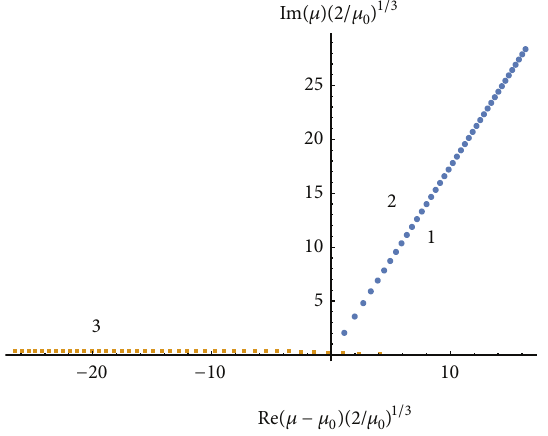
Figure 1: Position of Regge poles for attractive Fermi-potential. Shown are the poles, corresponding to near-surface states. 1: narrow quasi-bound states (whispering gallery states), 2: surface waves, and 3: narrow over-barrier resonances.